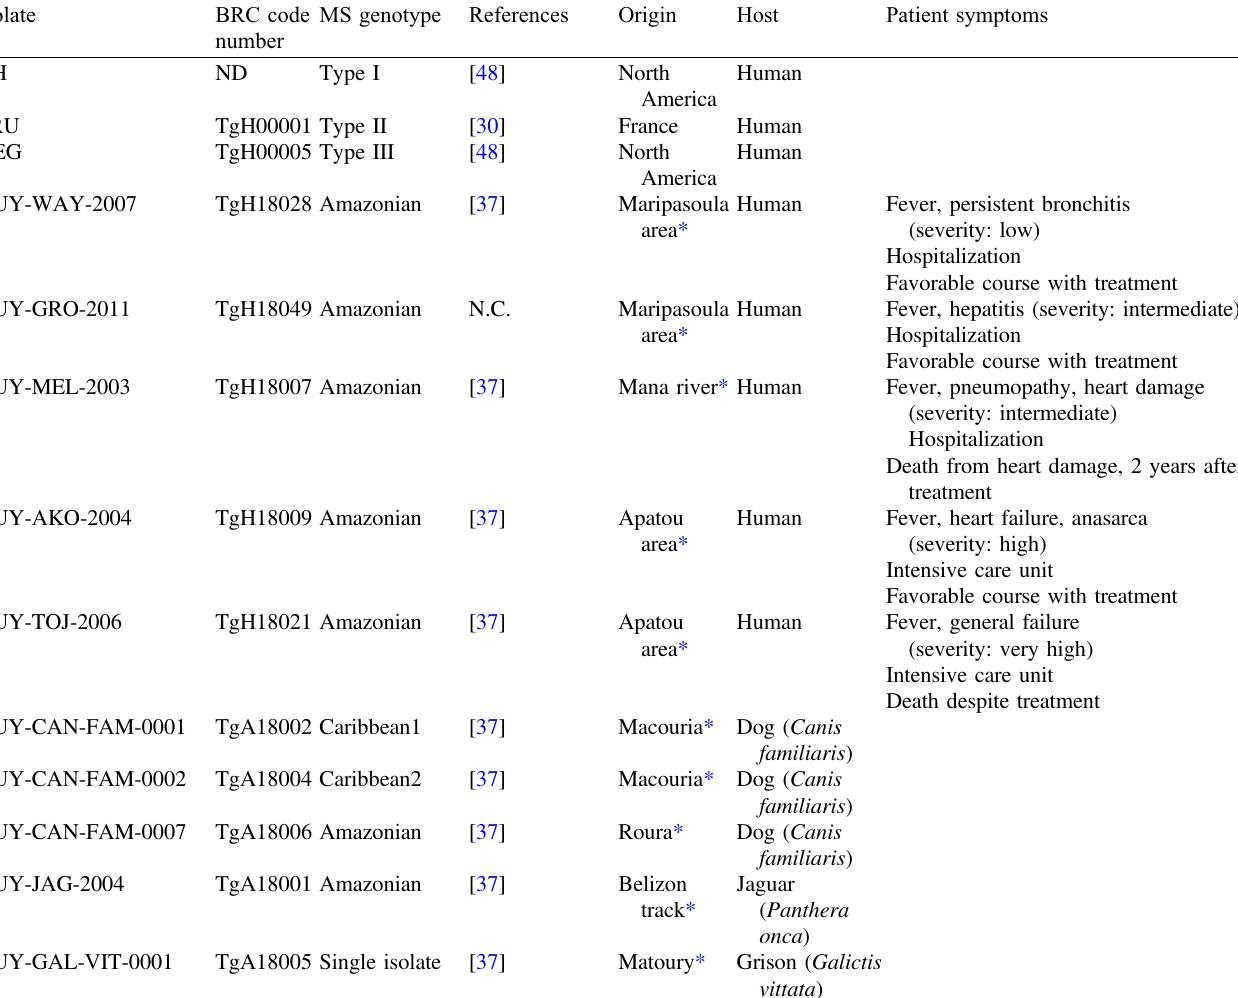
Table 1. Characteristics of the Toxoplasma gondii strains used in this study.